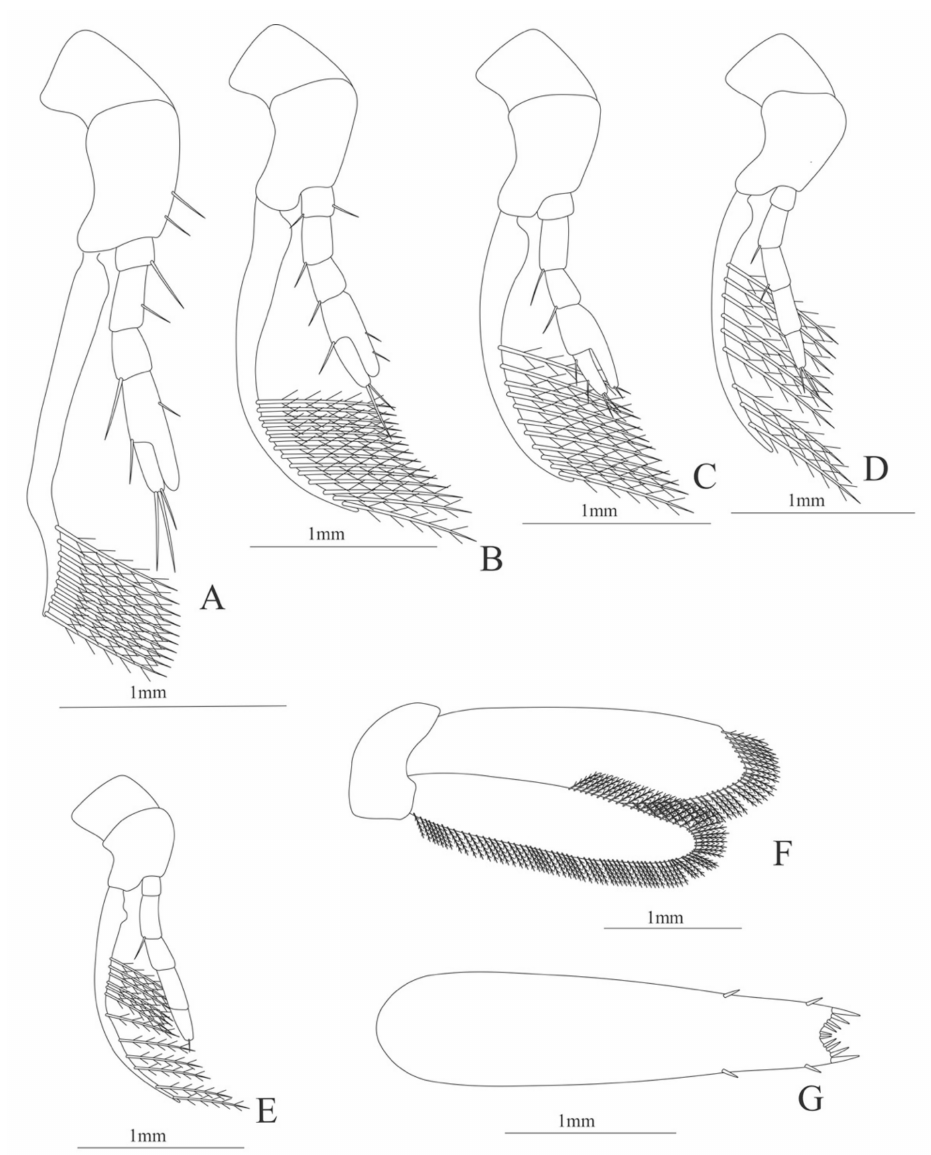
Figure 26. Hemipenaeus carpenteri : ( A ) first pereopod; ( B ) second pereopod; ( C ) third pereopod; ( D ) fourth pereopod; ( E ) fifth pereopod; (F ) uropods; ( G ) telson. Pleon (Figure 27A) with 6 somites, no spines or setae. Pleopods without setae. Antennule (Figure 27B). Peduncle 3-segmented, article 1 the longest, slender,